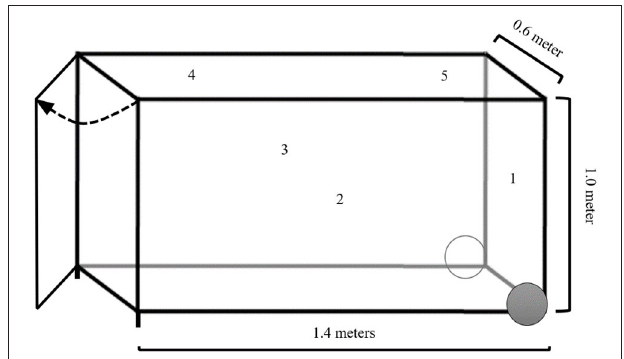
FIGURE 2 | Diagram and the dimensions of the isolation box and the location of the accelerometers on the outside of the box. The positions on the outside of the isolation box for the accelerometers are (1) back, (2) left, (3) right, (4) top-front, and (5) top-back.